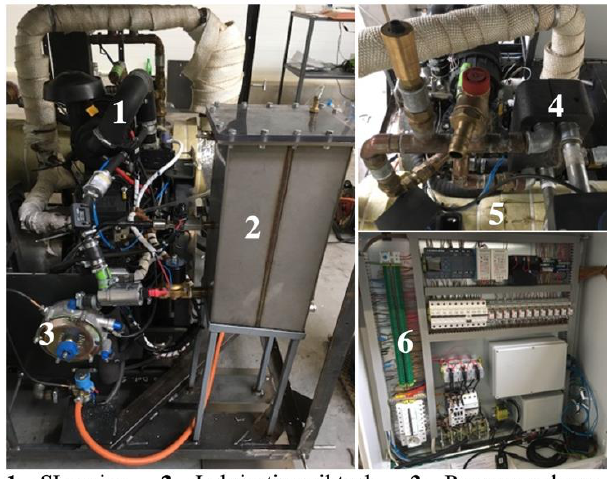
Fig. 4. Image of selected elements of the prototype